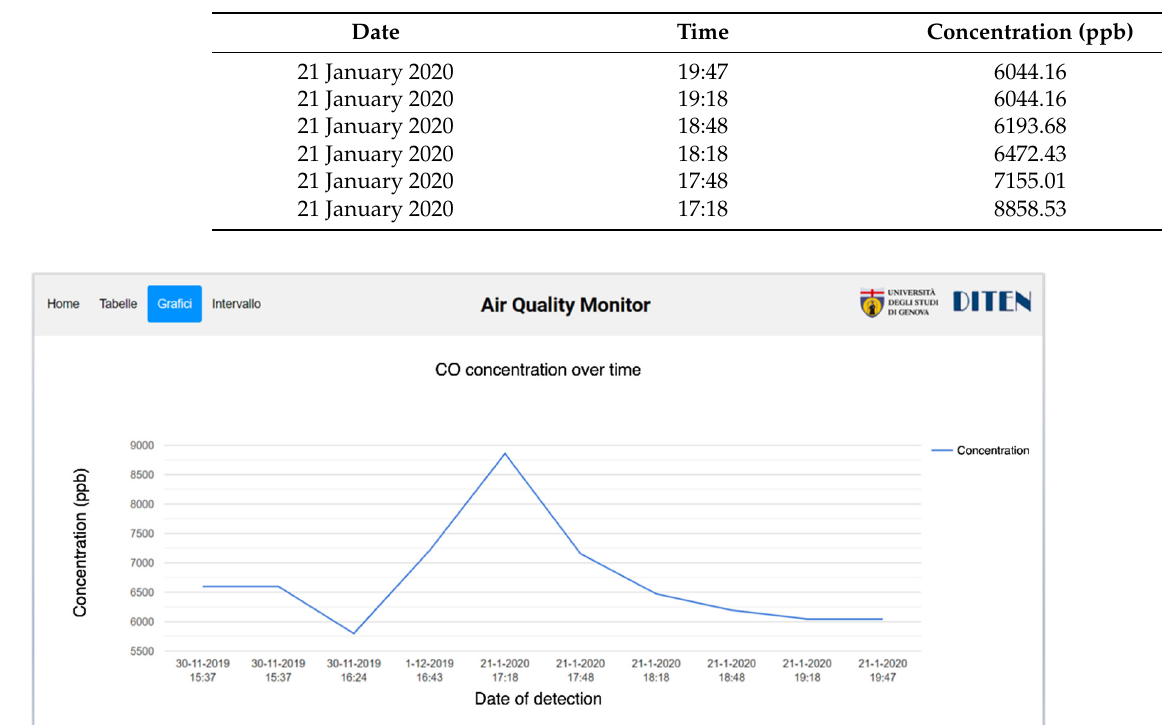
Figure 9. Measurements of the air quality system related to CO2 concentration in graphical format.